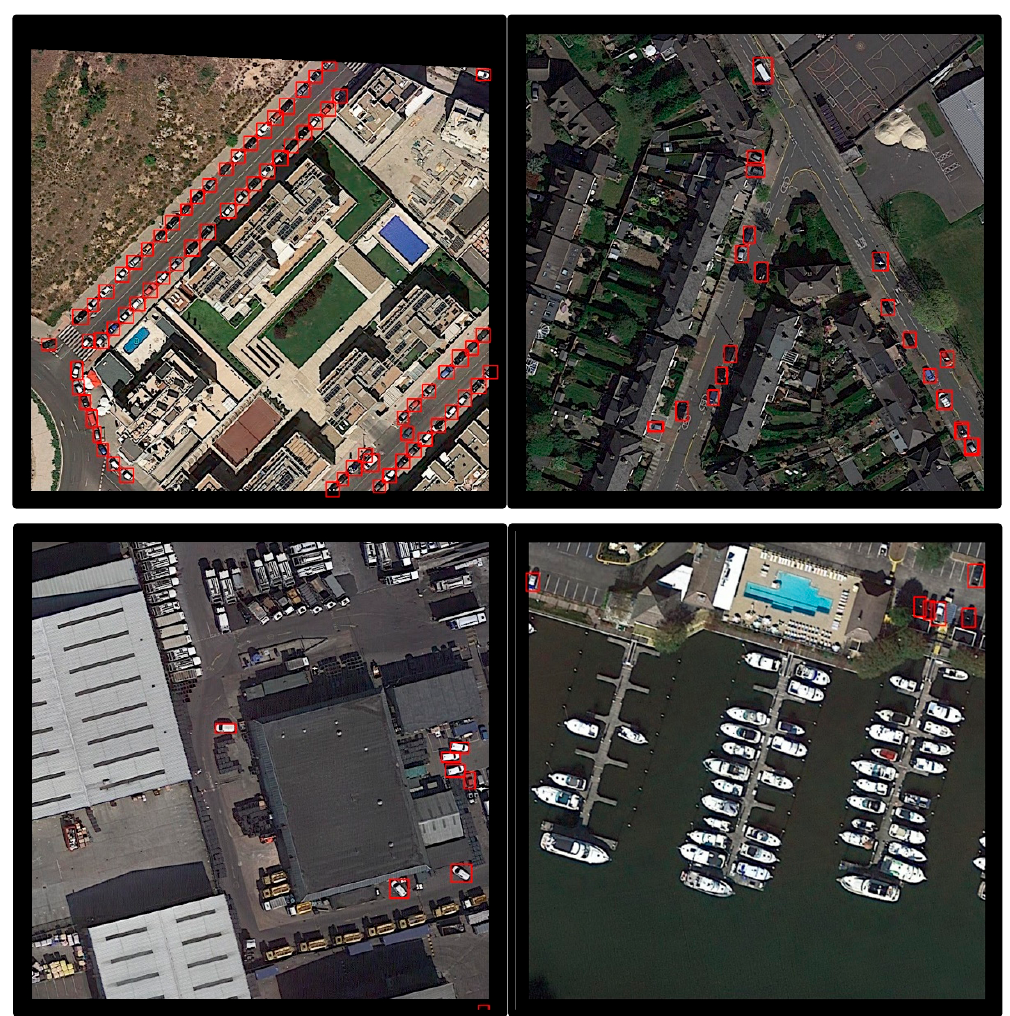
Figure 13. Detection samples on DOTA dataset using framework 1.2.